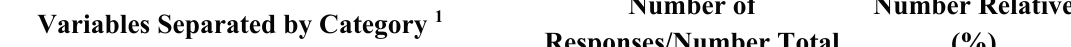
Table 2. Environmental features around the residences of respondents who live in areas near the Mossoró River, neighborhoods Ilha de Santa Luzia, Alto da Conceição and Paredões in the city of Mossoró, Rio Grande do Norte,